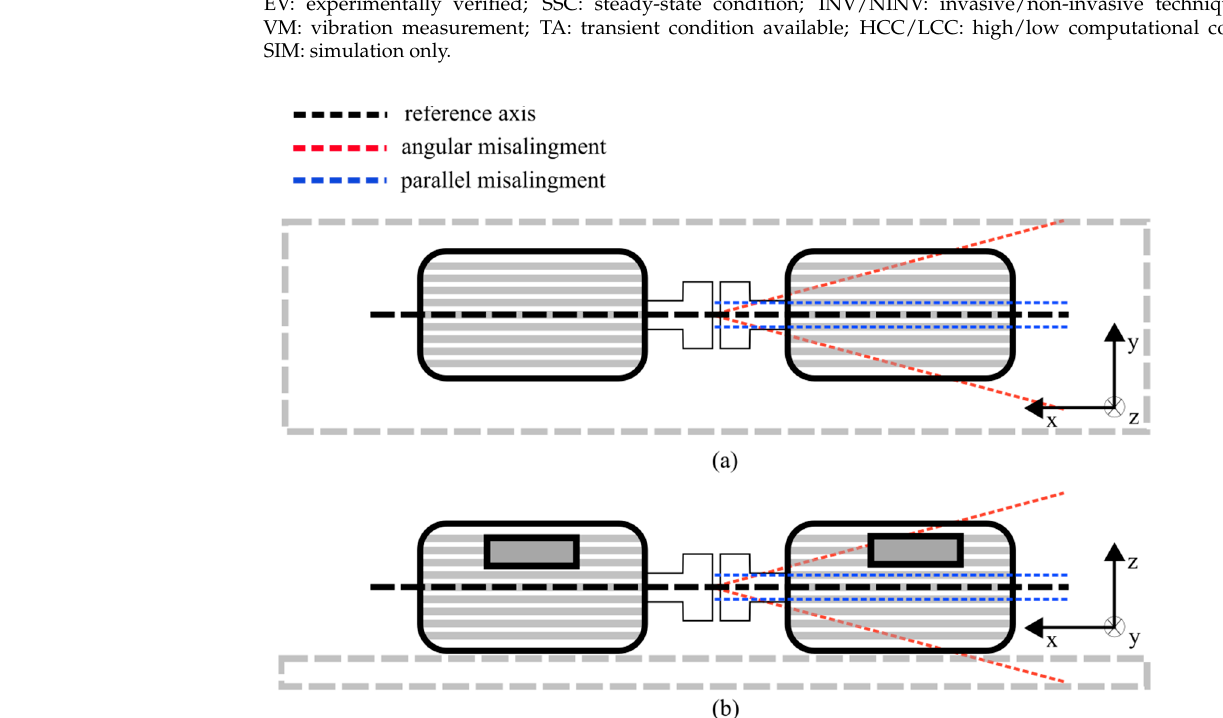
Table 6. Classification of detection methods for rotor misalignment faults in PMSMs. Type of Motor